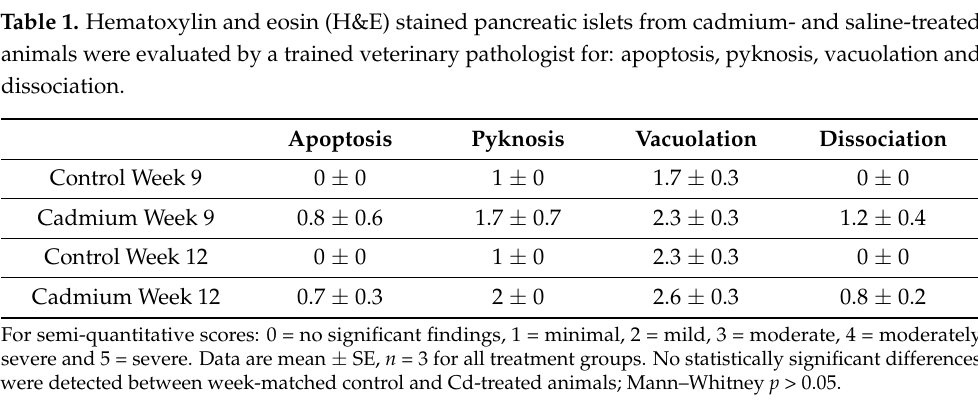
For semi-quantitative scores: 0 = no significant findings, 1 = minimal, 2 = mild, 3 = moderate, 4 = moderately severe and 5 = severe. Data are mean ± SE, n = 3 for all treatment groups. No statistically significant differences were detected between week-matched control and Cd-treated animals; Mann–Whitney p >